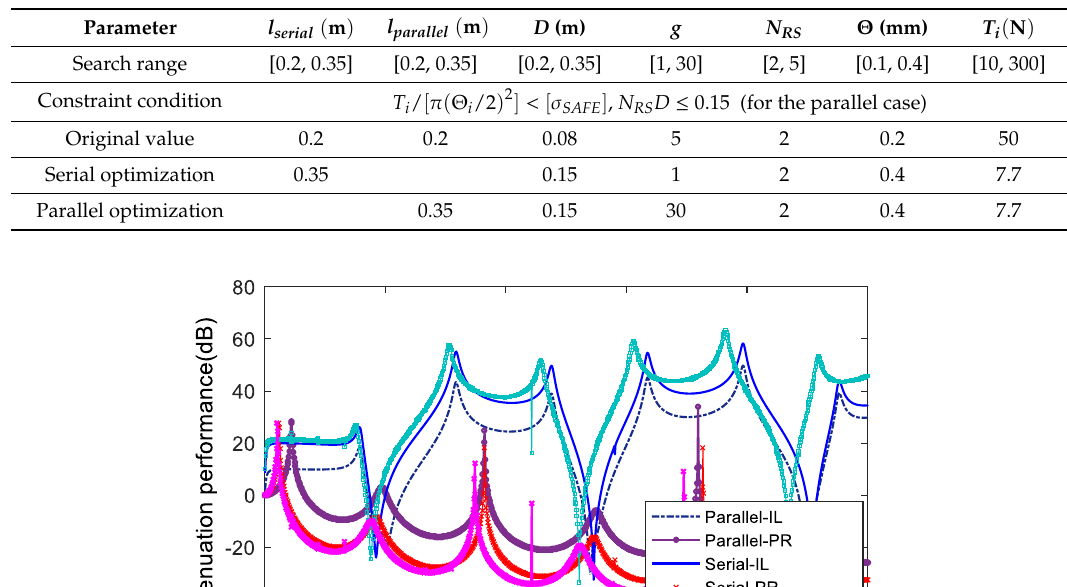
Figure 12. Schematic diagram of serial and parallel combinations of RSHPA.